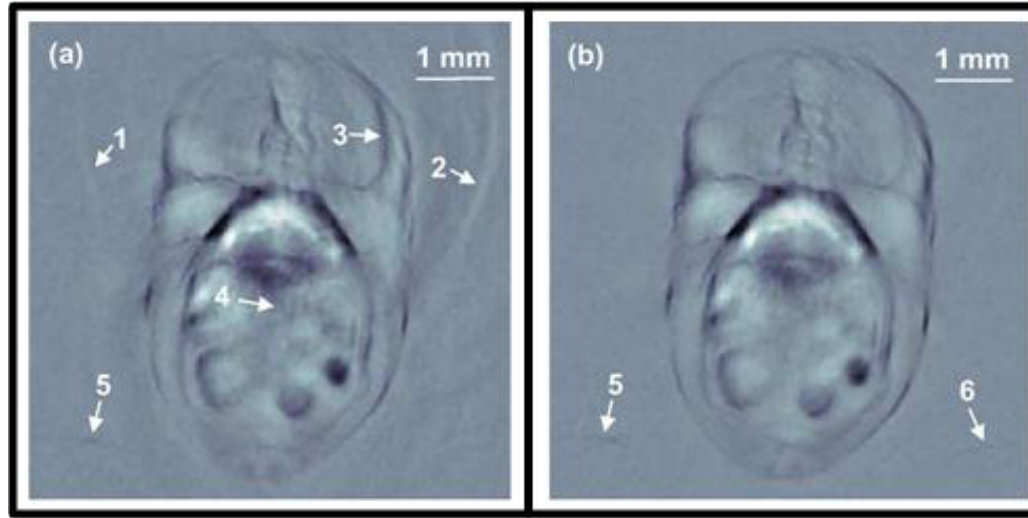
Figure 5. OA reconstruction of a zebra fish in the highly mismatching region of the swim bladder by Dean-Ben et al. [113]. ( a ) Reconstruction with universal back-projection algorithm (1–3: reconstruction artifacts; 4: smeared region near the liver; 5 + 6: pectoral fins); ( b ) Reconstruction with the statistically weighted back-projection algorithm accounting for the acoustic mismatch and reducing the image artifacts. Reprinted with permission from IEEE